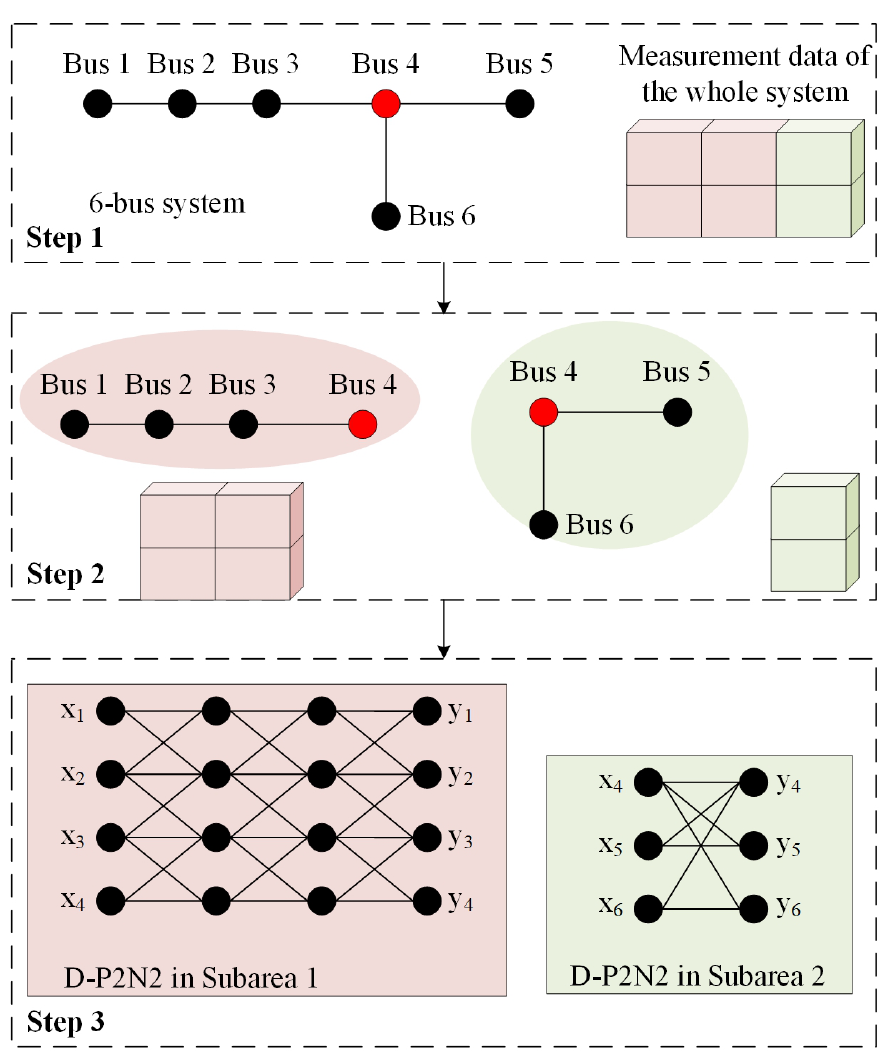
Figure 6. Decentralized training and execution of D-P2N2